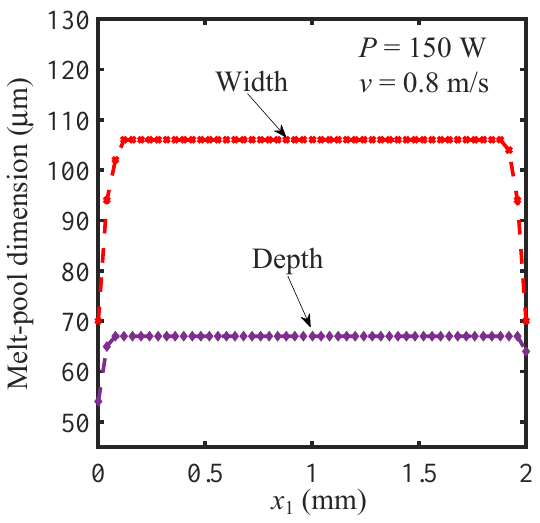
Figure 6. The melt-pool width and depth along the laser scanning line at the power of 150 W and the speed is 0.8 m/s.